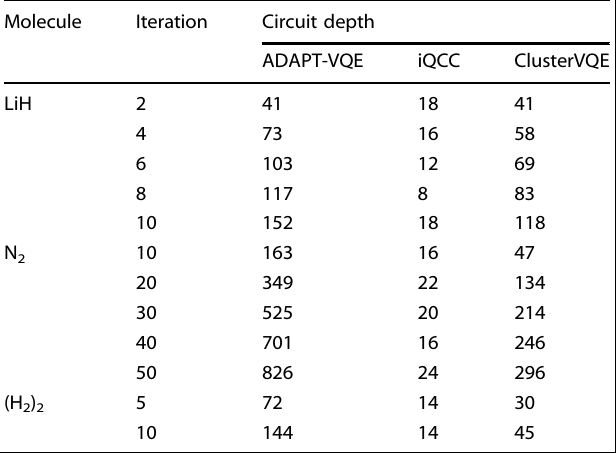
Table 1. Circuit depth of each method with the QUCCSD ansatz. The LiH and N 2 molecules used in this table are in equilibrium is 2 Å. The circuit con fi gurations. The intermolecular distance of ð H 2 Þ 2 depths of VQE with 1 layer QUCCSD ansatz are 352, 1535, and 331 for LiH, N 2 , and ð H 2 Þ , 2